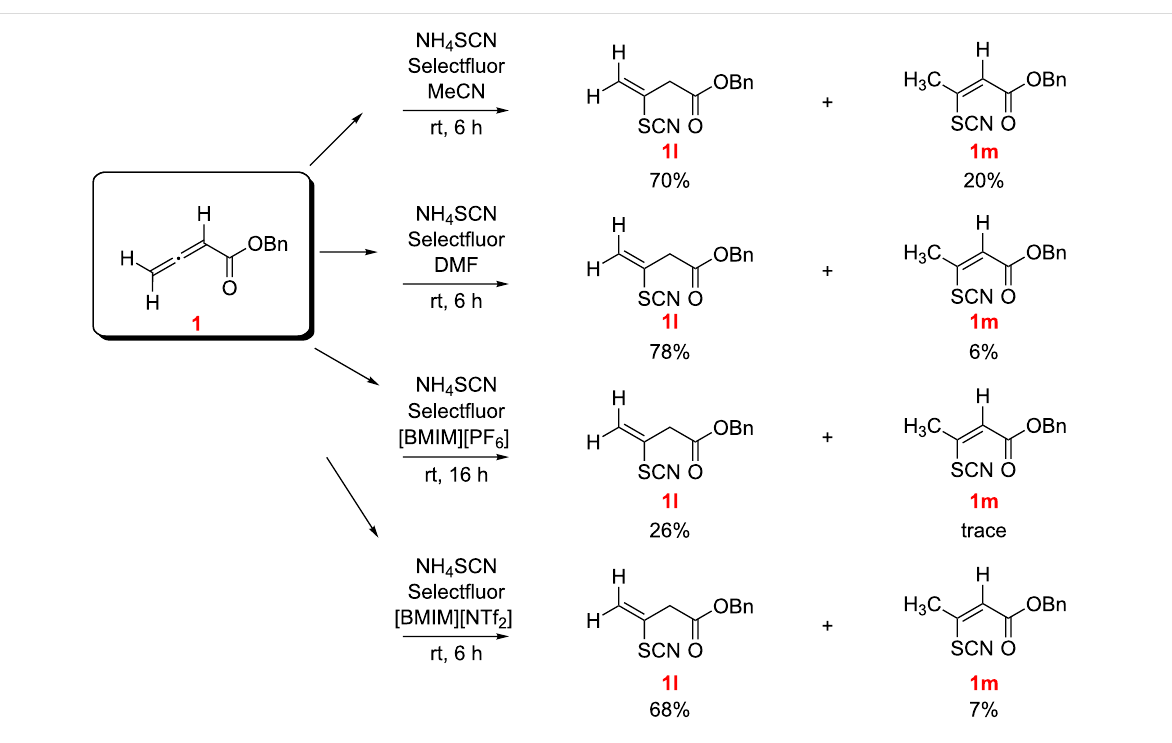
Scheme 4: Reaction of benzyl allenoate ( 1 ) with NH 4 SCN/Selectfluor in different solvents ( E/Z designations, as illustrated, were made by NMR; see Supporting Information File